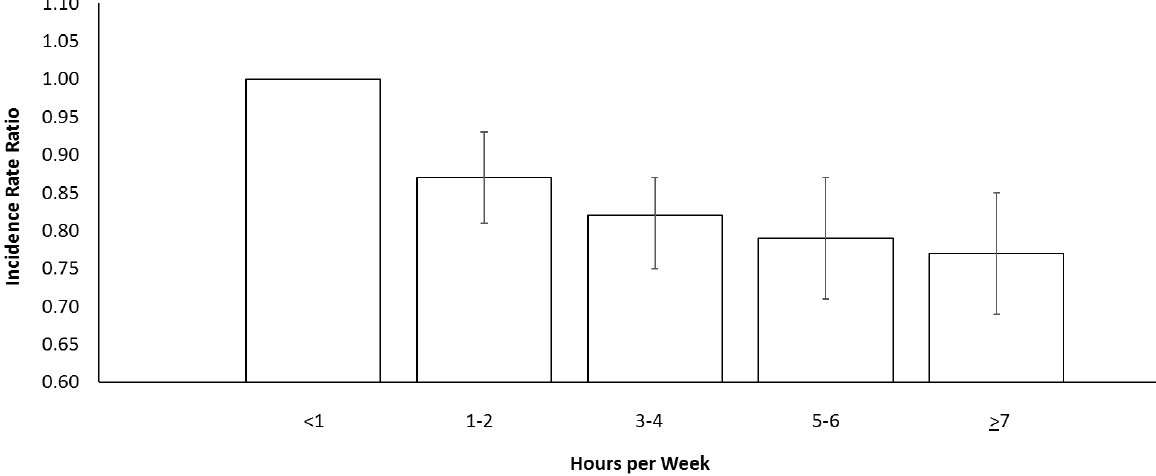
Figure F5-2. Incidence Rate Ratio of Developing Obesity at Various Levels of Vigorous Physical Activity